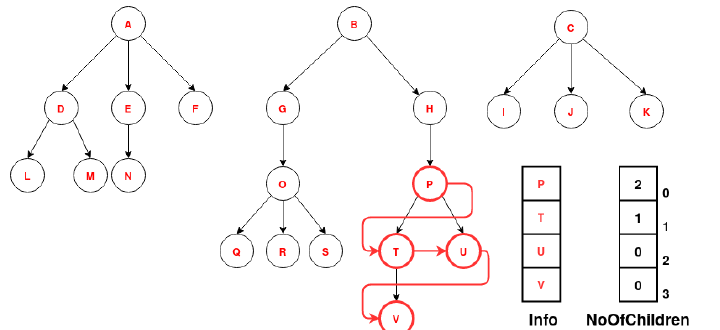
Figure 4. Sub-Tree